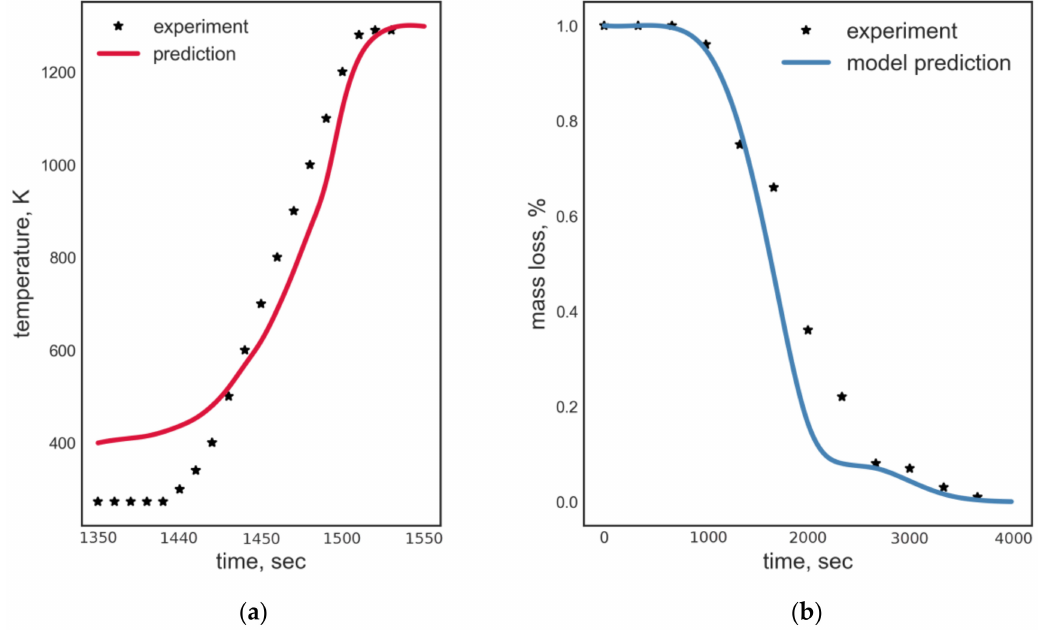
Figure 4. Model validation: ( a ) temperature evolution versus Reference [40], ( b ) mass loss versus Reference